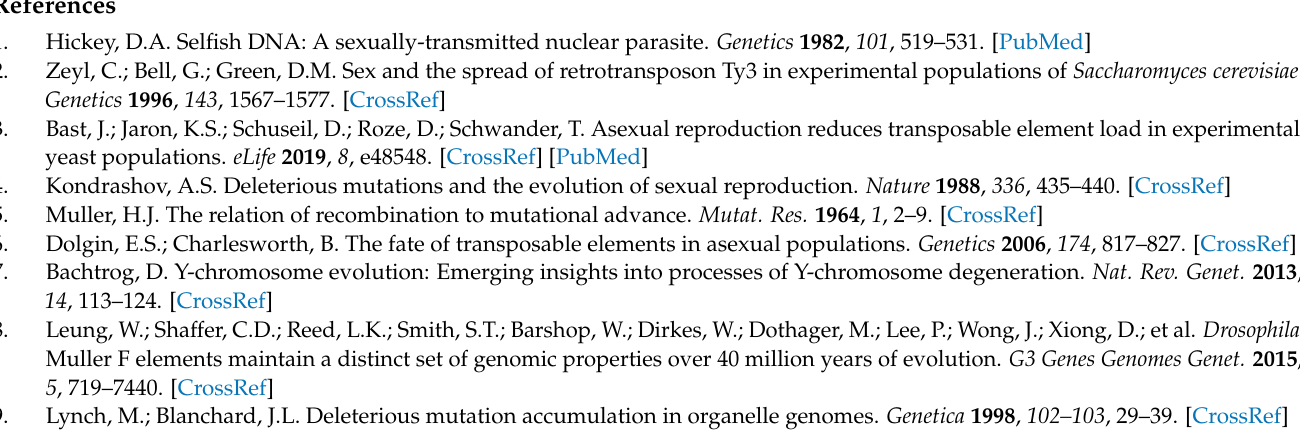
Figure S2: Comparison of sequence features between three groups of fosmids. Table S1: Probes used for hybridization and detection of fosmids containing TEs or telomeres. Table S2: Hybridization signal of selected fosmids for sequencing. Table S3A: Contig sequence features. Table S3B: Fosmid sequence features. Table S4: Overview of possible overlap between contig ends. Table S5: Results of TE identification with